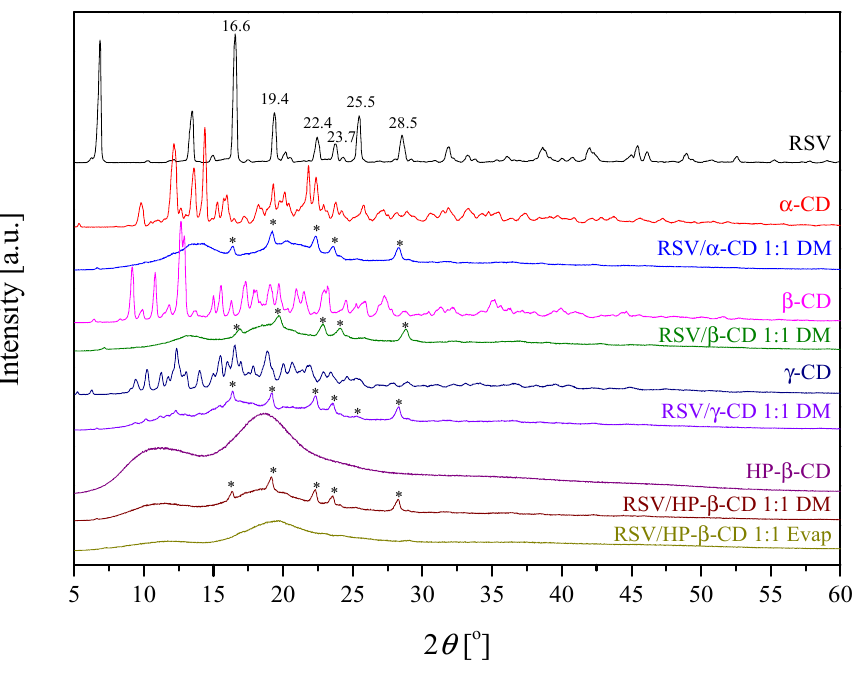
Figure 1. X-ray diffractograms of the solid samples. 2 θ positions of the principal diffraction peaks are shown for RSV, whereas the traces of crystalline RSV peaks in the systems are indicated by “*”. Against that, the RSV/HP- β -CD pattern had no diffraction peak corresponding to RSV, which suggests that the RSV no longer exists in a crystalline form when complexing with HP- β -CD within the evaporation process, although it exists in an amorphous state [46]. Additionally, since HP- β -CD is in higher energy amorphous state, the simple co-grinding mechanochemical activation process was enough to break the RSV crystal lattice, resulting in almost complete amorphization and complex formation. In fact, this is consistent with the solid-state inclusion complex formation mechanism, which required a particle size reduction and the development of crystal lattice defects, and then formation of complex on the reactants surface. To sum up, PXRD patterns confirmed the inclusion complex formation between CDs and RSV. Diffractograms for all obtained systems are presented in the Supplementary Material (Figure S1). The powder RSV/CD systems were further characterized by FTIR. Due to the different number of glucose units in the cyclodextrin structures ( α -CD, β -CD, HP- β -CD, γ -CD), slight differences were visible in the IR spectra of pure molecules (Figure 2). The changes are evident in such ranges as 500–900 cm − 1 , in which bending vibrations in the plane and outside of the O–H, C–H bonds as well as C–C and C–O stretching vibrations are observed. Moreover, shifts of the three most intense bands are visible for the characteristic bands related to the stretching vibrations of C–O and C–C bonds (1000–1200 cm − 1 ). In the case of the HP- β -CD spectrum, special attention should be paid to the disappearance of the 998 cm − 1 bands. This is due to the presence of the attached hydroxypropyl groups. The influence of these groups on the character of the spectrum is also visible around 3000 cm − 1 , where an additional component is registered at 2970 cm − 1 at the band of 2928 cm − 1 (vibration of the C–H bonds